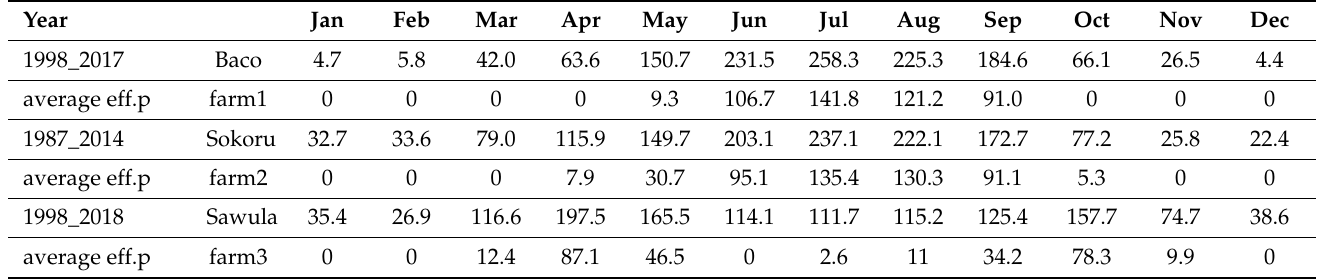
Table 3. Average precipitation in the Omo_Gibe river basin (mm/month).